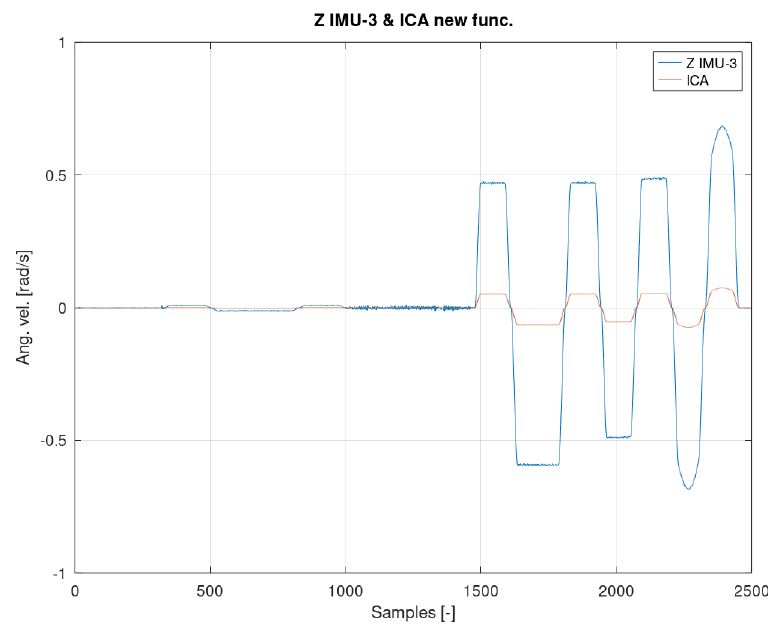
Figure 15. Analysis of the error from Figure 14 with the DTW algorithm.